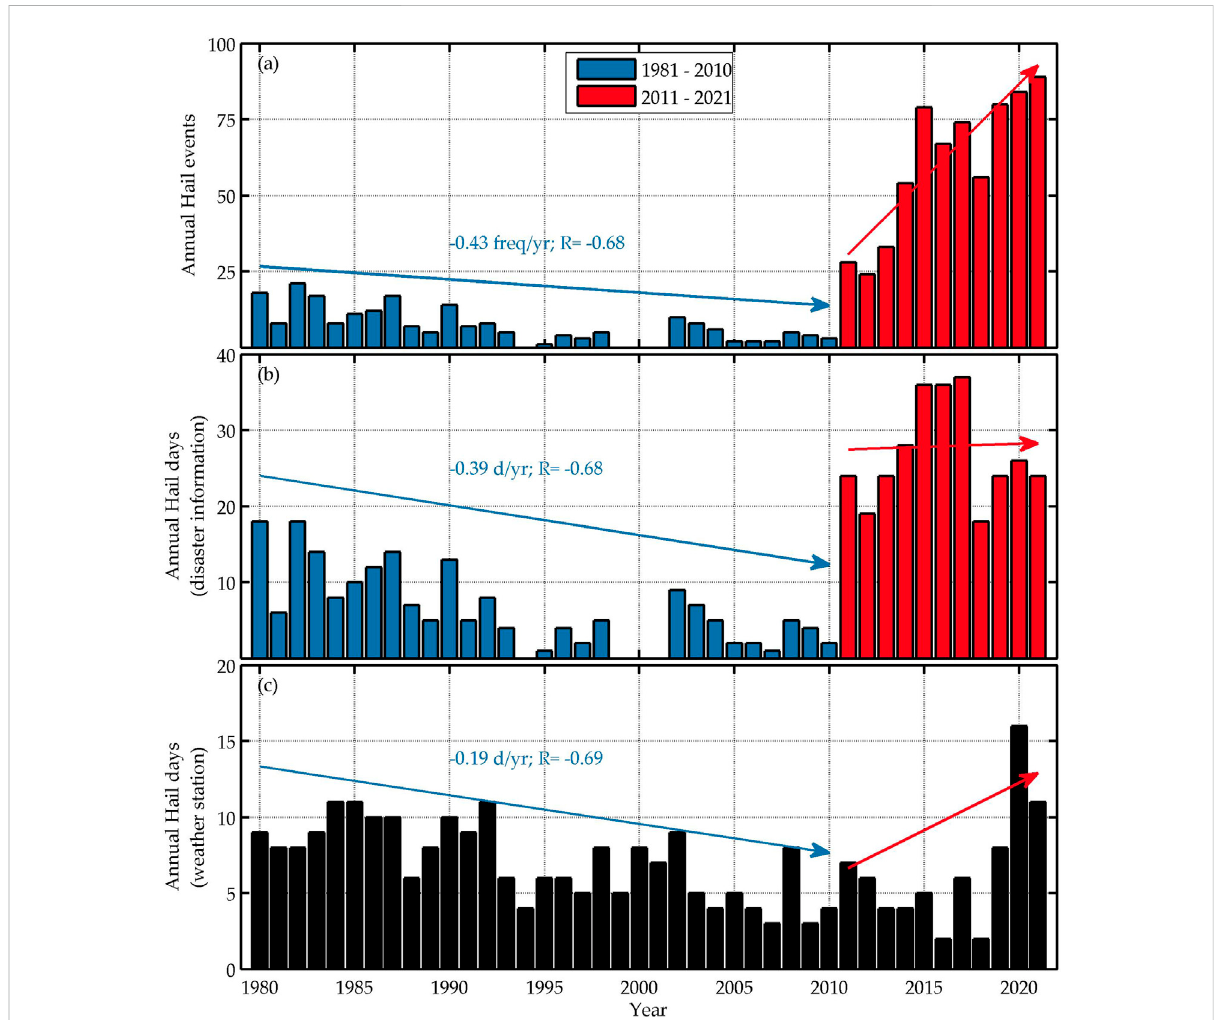
FIGURE 2 Annual variations of hail events and days in Beijing from 1980 to 2021: (A) . Annual hail events collected from disaster information dataset; (B) . Annual hail days collected from disaster information dataset; (C) . Annual hail days collected from national weather station measurements. Blue/red barsshow disasterinformationdatainthetimeperiodof1981 – 2010/2011-2021;blackbarsshowweatherstationdata;blue/redarrows showtrends of the annual variations in the time period of 1981 – 2010/2011-2021, respectively.